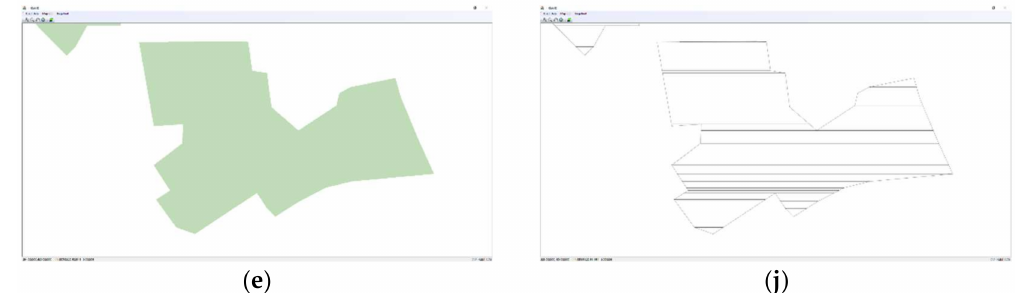
Figure 7. Screenshots of polygon level of detail (LoD) rendering [2]. ( a – e ) are the rendered results of the test polygons at five zoom levels (1:250,000, 1:80,000, 1:50,000, 1:29,000, 1:3,000, respectively), while ( f – j ) are the corresponding adapted trapezoidal meshes.